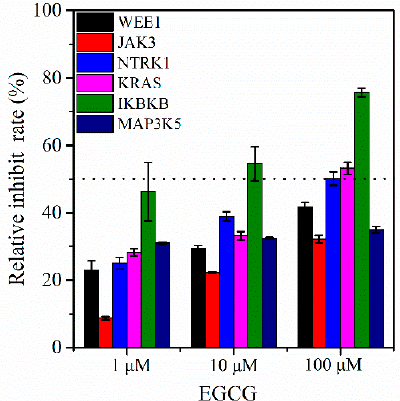
Figure 8. Relative inhibit rate of EGCG potential targets.